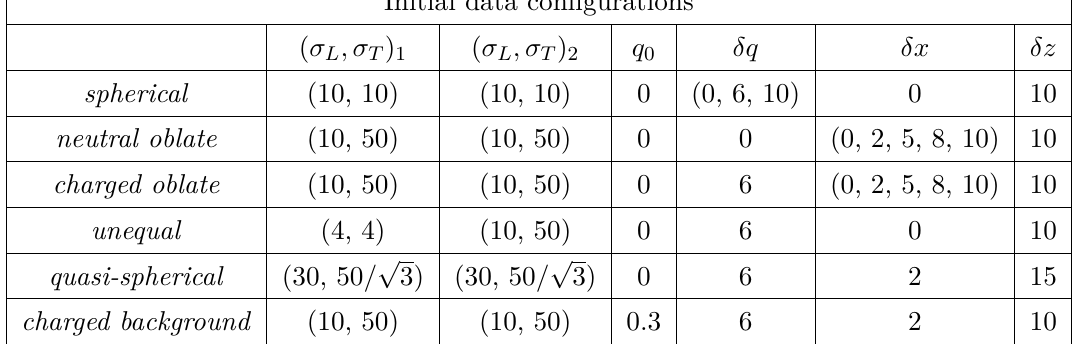
Table 1 . Symmary of parameters in inital data configurations. All of them share δρ = 20 , δp = 60 . Through the text we will refer to the different collisions by the names given in this